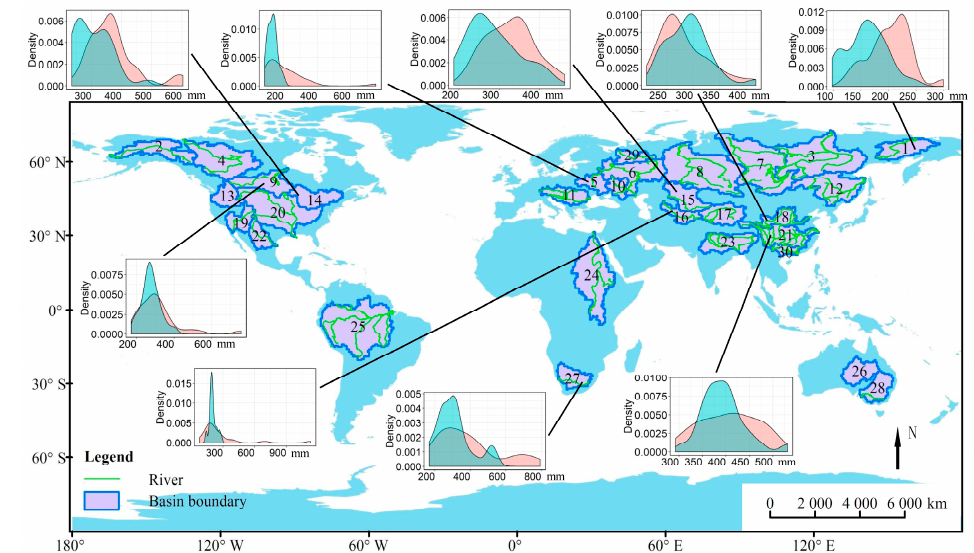
Figure 5. Changes in frequency distributions of maximum three-day precipitation RX3day for different river basins. The green and pink shadings in each panel represent the distributions for the period of 1960–1984 and 1985–2011, respectively. The x-axis in each panel shows amount of RX3day and the y-axis is the corresponding frequency distribution density.